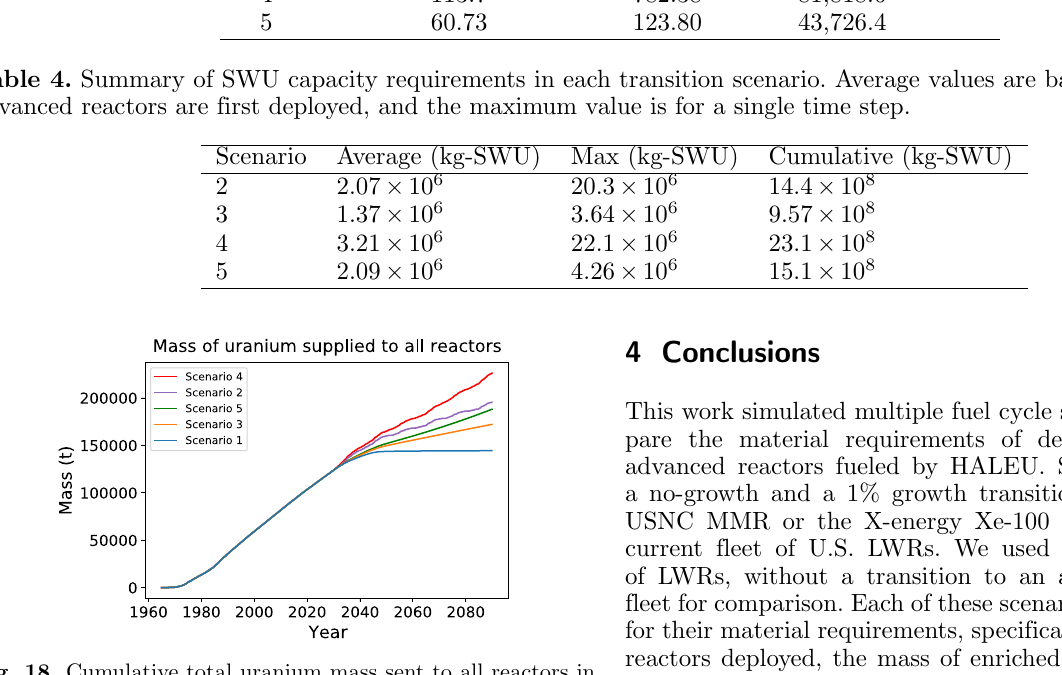
Fig. 18. Cumulative total uranium mass sent to all reactors in each